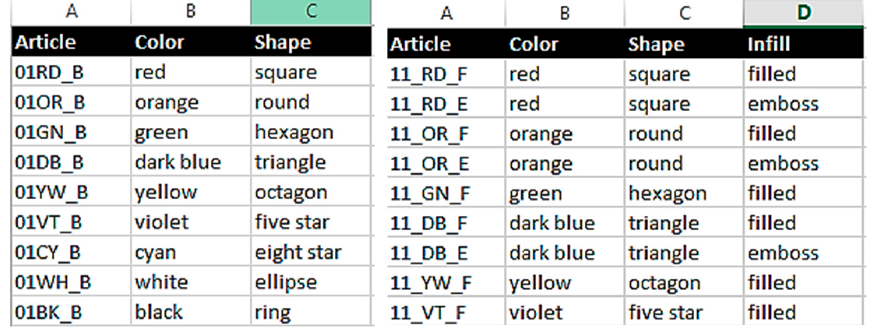
Figure 6. Spreadsheet definition for slot ( left ) and brick ( right ) domain.